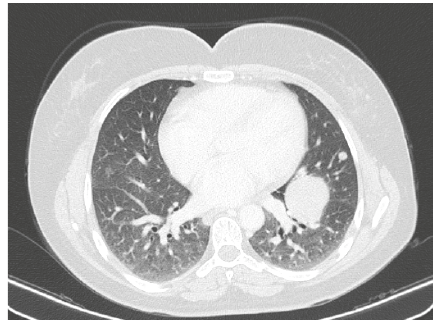
Figure 2: Chest CT, axial image. There is a soft tissue density mass measuring 44 mm and an 8mm nodule, both in the left lung.